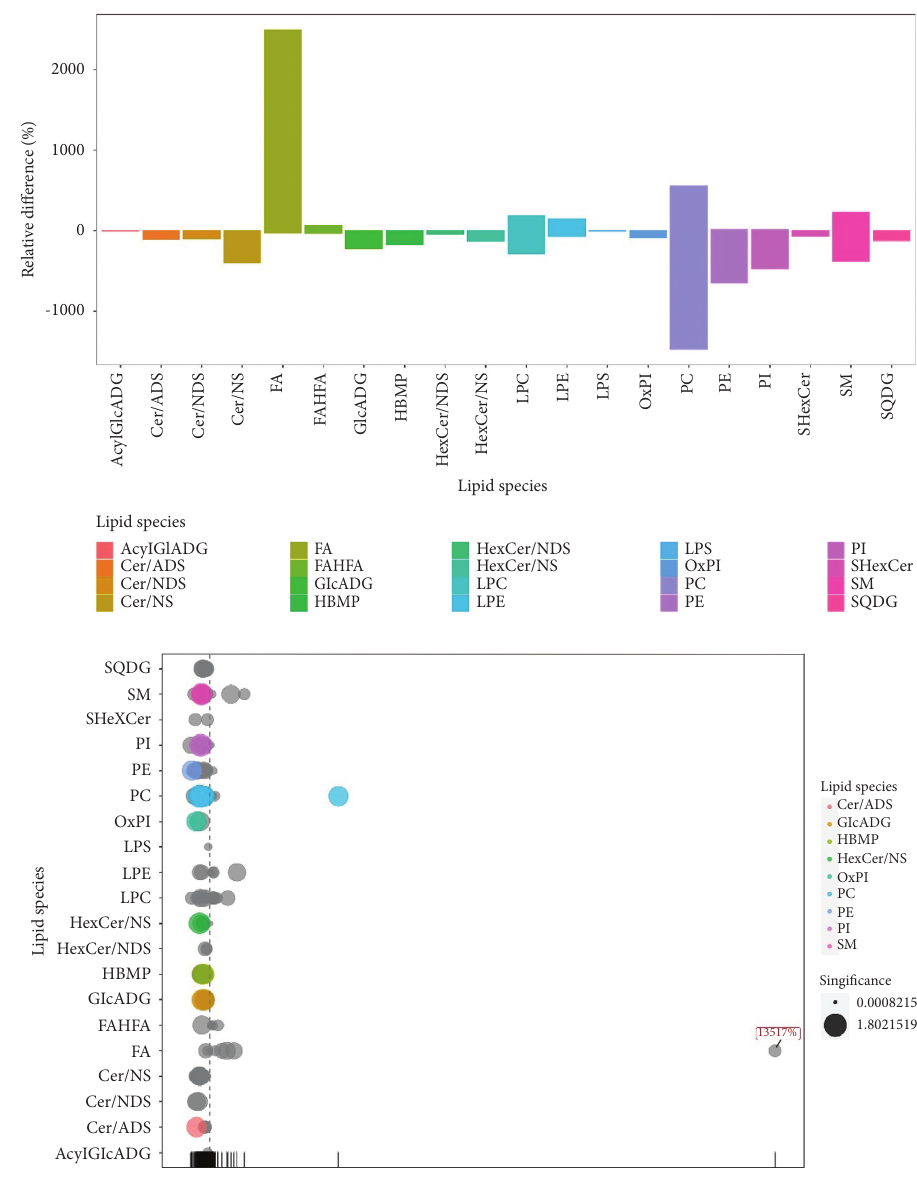
Figure 10: Histogram and bubble plot of lipid group in ordinary rice group-high dose reconstituted rice group (negative ion